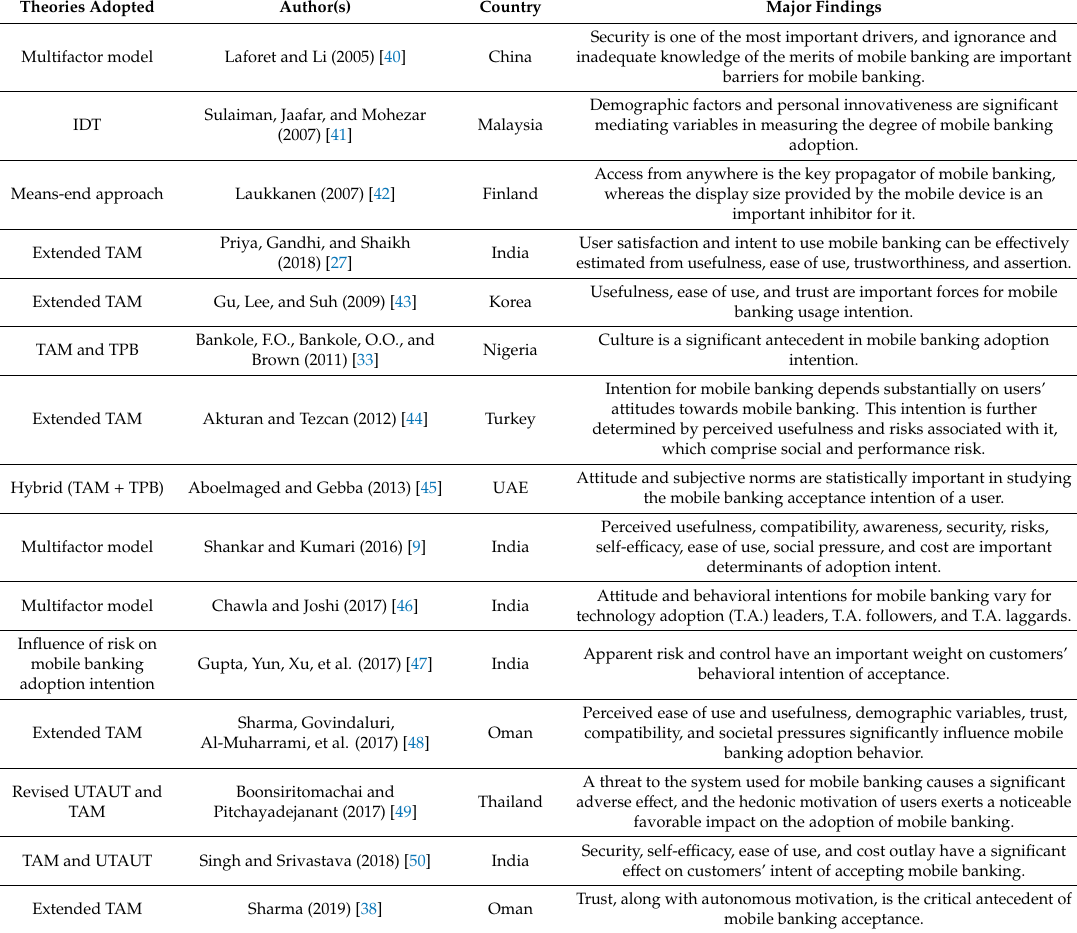
Table 2. Empirical Studies on Mobile